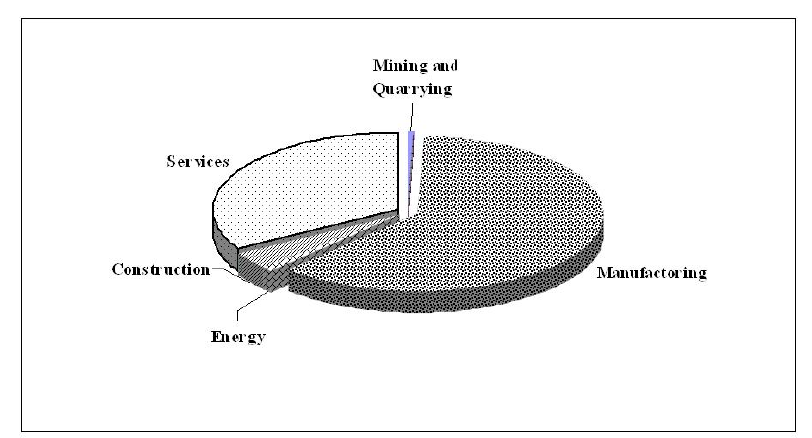
Figure 1 – Distribution of panel firms by economic activity – Year 1998.